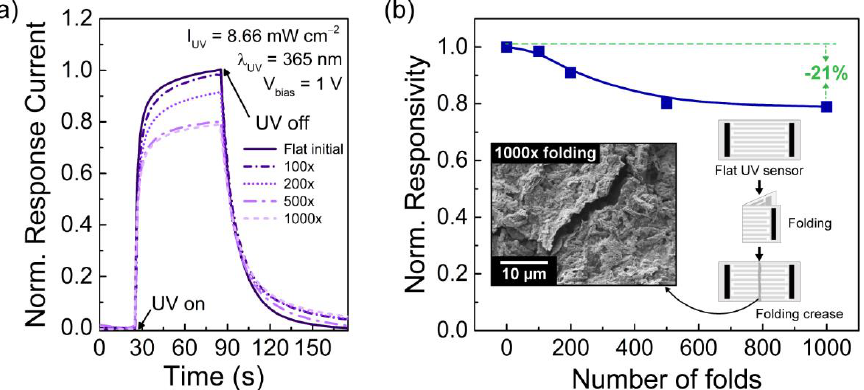
Figure 5. ( a ) Average photoresponse of the screen-printed CMC/ZnO UV sensor on office paper for different UV light intensities under a bias voltage of 1 V. ( b ) Response current and respective responsivity for different UV light intensities.